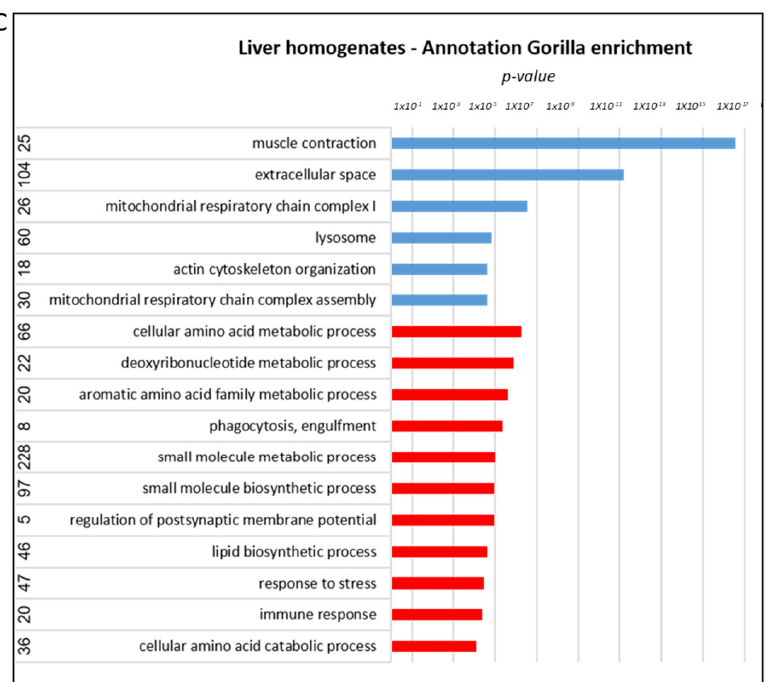
Figure 8. Proteomics analysis of the liver. ( A ) Heatmap showing proteins significantly altered across all group comparisons (non-AD, AD, and treated AD) in liver homogenates. Red is indicative of upregulation while green is indicative of downregulation. ( B , C ) Annotation analysis. ( B ) KEGG/GOTERM (names of affected proteins presented in brackets; full names of proteins are presented in Table S1 and Supplemental-liver-proteomics-excel). ( C ) Gorilla enrichment of the liver. AD > treated AD—marked in blue, AD < treated AD—marked in red.